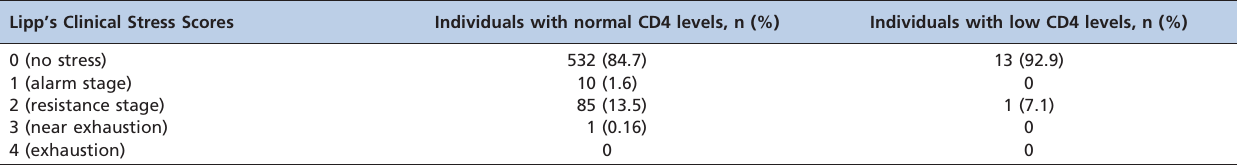
Table 4 - Clinical stress score distribution between peacekeepers with normal CD4 levels (n= 628) and low CD4 counts (n=